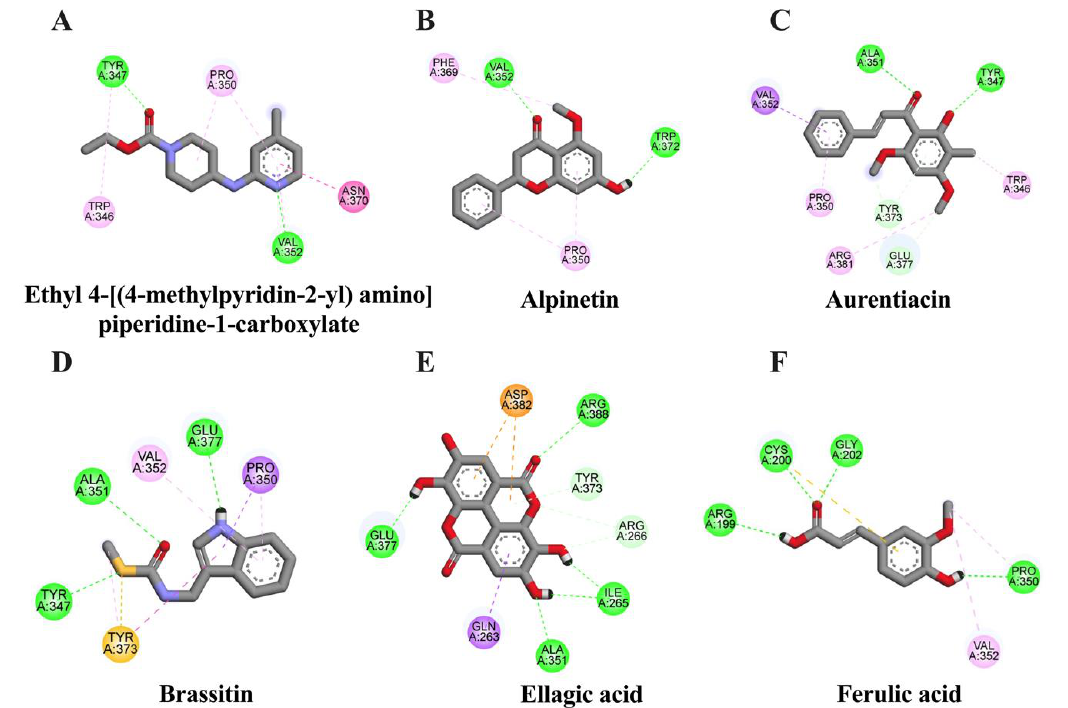
Figure 4. Schematic interactions of amino acid residues between reference inhibitor or candidate compounds and iNOS protein. The original inhibitor of iNOS protein is ( A ) ethyl 4-[(4-methylpyridin-2-yl) amino] piperidine-1-carboxylate and candidate ligands are as follows: ( B ) alpinetin, ( C ) aurentiacin, ( D ) brassitin, ( E ) ellagic acid, and ( F ) ferulic acid. The green dashed line represents hydrogen, the pink or purple dashed lines represent hydrophobic bonds, and the yellow dashed line indicates other bonds. Table 4. Molecular docking results of top 5 identified compounds to COX-2 binding